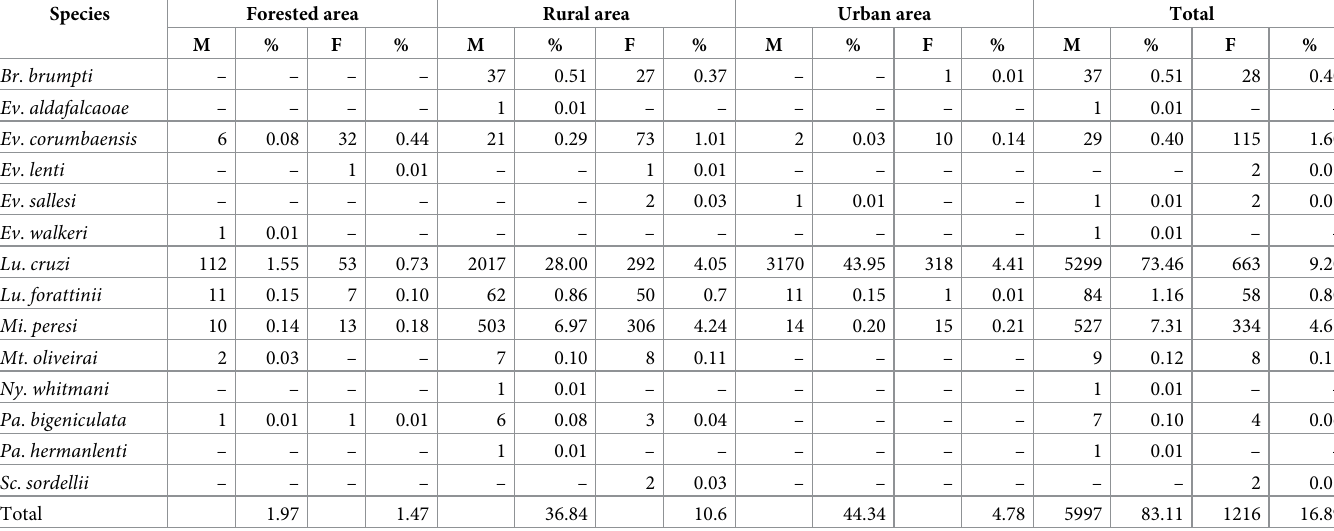
Table 4. Distribution of male and female specimens ( n = 7213). Corumba´, Mato Grosso do Sul, Brazil. May 2015 to April 2017. Species Forested area